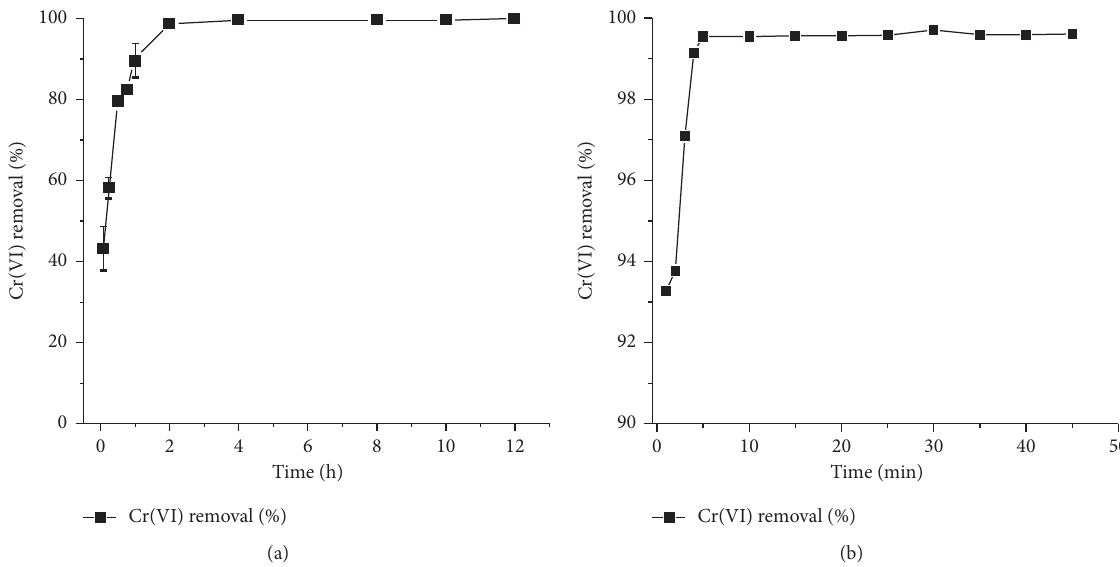
Figure 5: Effect of contact time on Cr(VI) removal by (a) TR and (b) PSS (conditions: initial concentration of Cr(VI) 5mg/L, adsorbent dosage 2.5 g/L, shaking speed 200 rpm, temperature 25 ° C, and pH